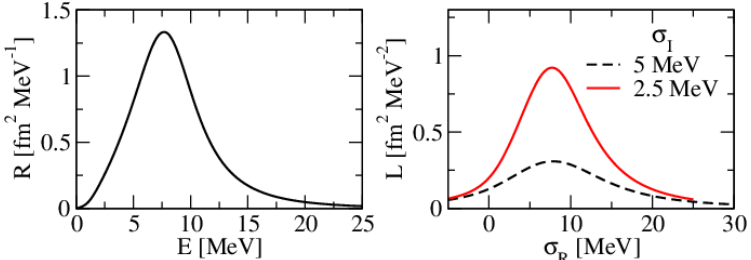
Figure 4: Left panel: the dipole response function R(E); right panel: the LITs of R(E) = 5 MeV (black dashed) and σ for σ I